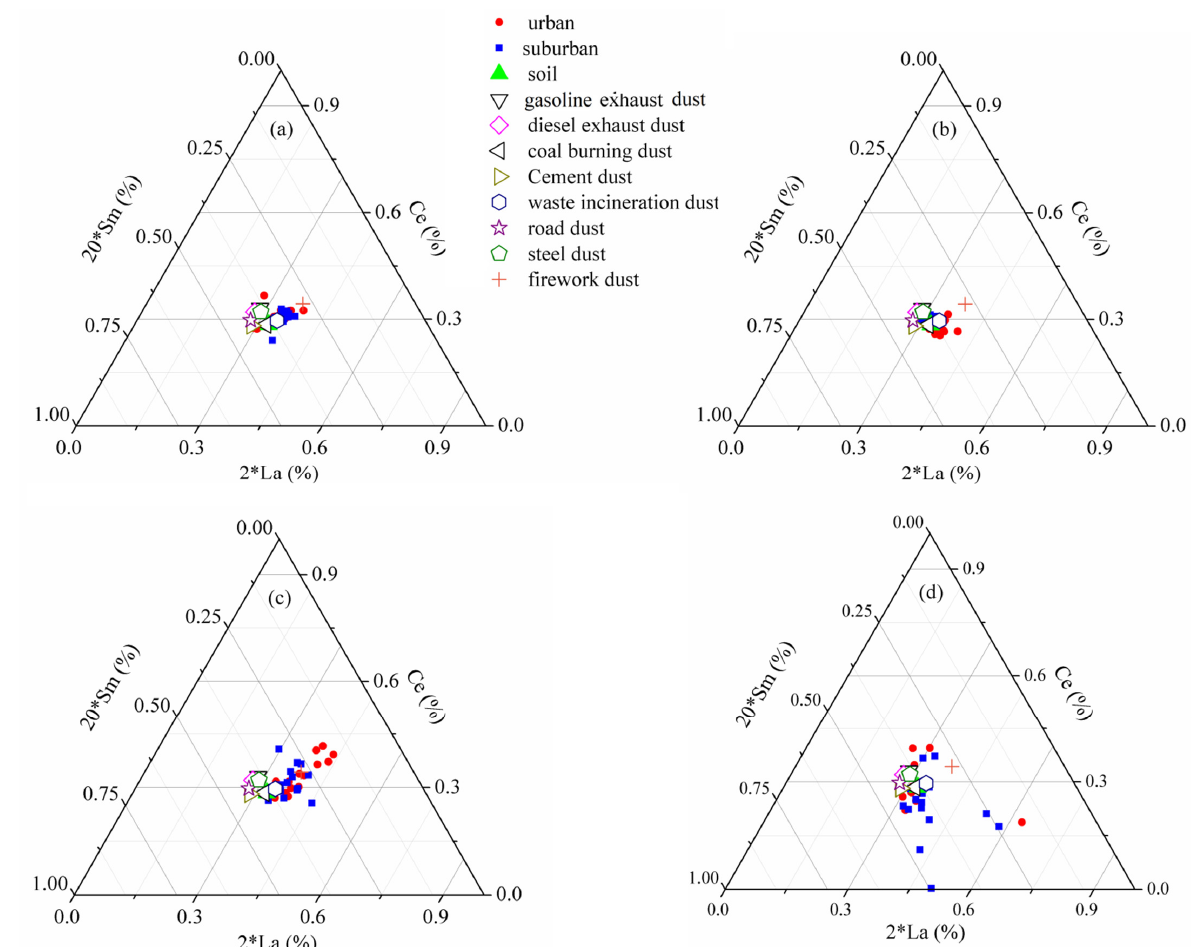
Figure 4. La-Ce-Sm ternary plots for PM 2.5 and potential sources in Xiamen. ( a – d ) represent spring, summer, autumn and winter, respectively.